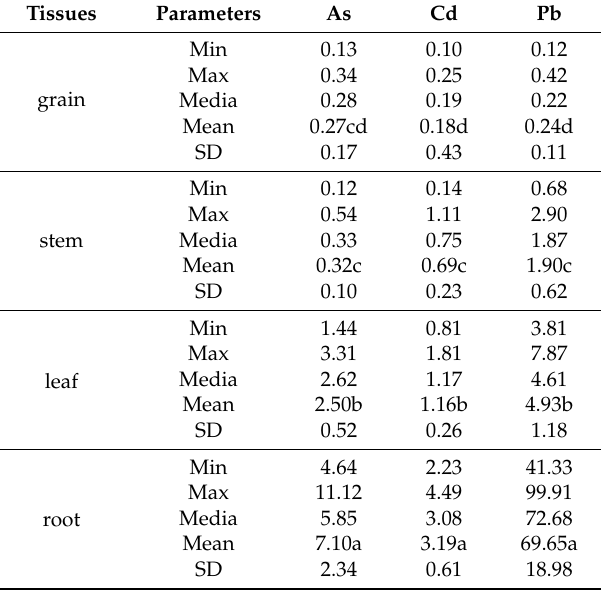
Table 3. Statistics summaries of As, Cd, and Pb in the grain, stem, leaf, and root in wheat cultivars (values followed by different lowercase letters represent significant differences in heavy metal concentrations in the wheat tissue). Tissues Parameters As Cd Pb Min 0.13 grain